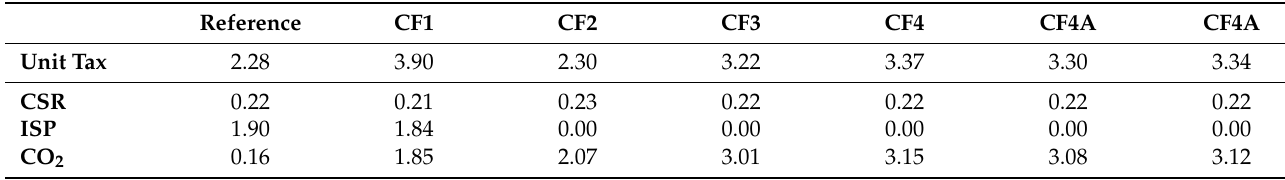
Table 6. Long run [2030] effects: energy